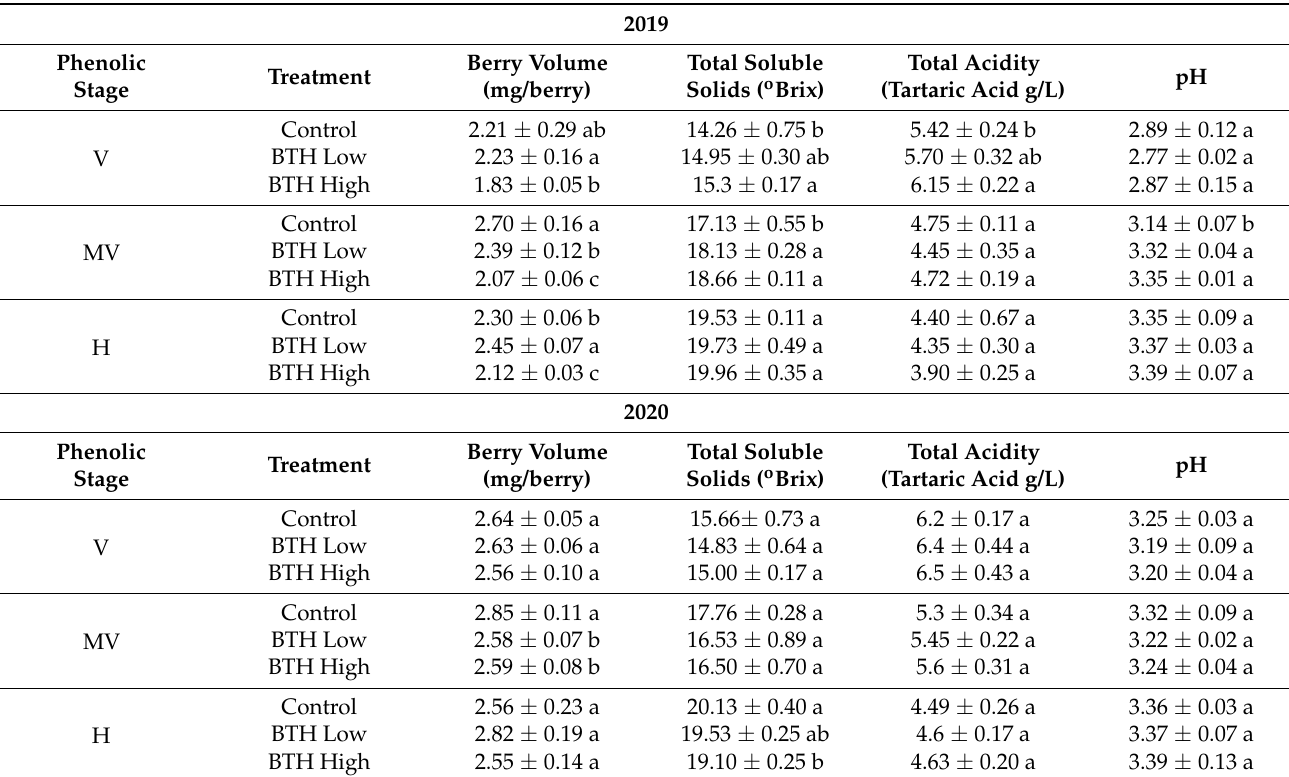
Table 2. Physicochemical characteristics of Savvatiano grapes at three phenological